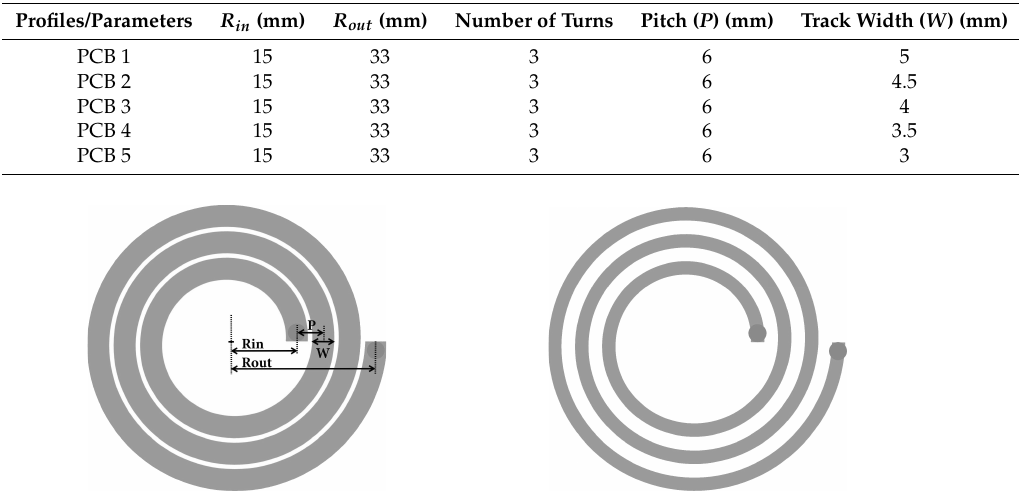
Figure 6. Three-turn W = 5 mm, P = 6 mm PCB winding ( left ) and W = 3 mm, P = 6 mm ( right ).